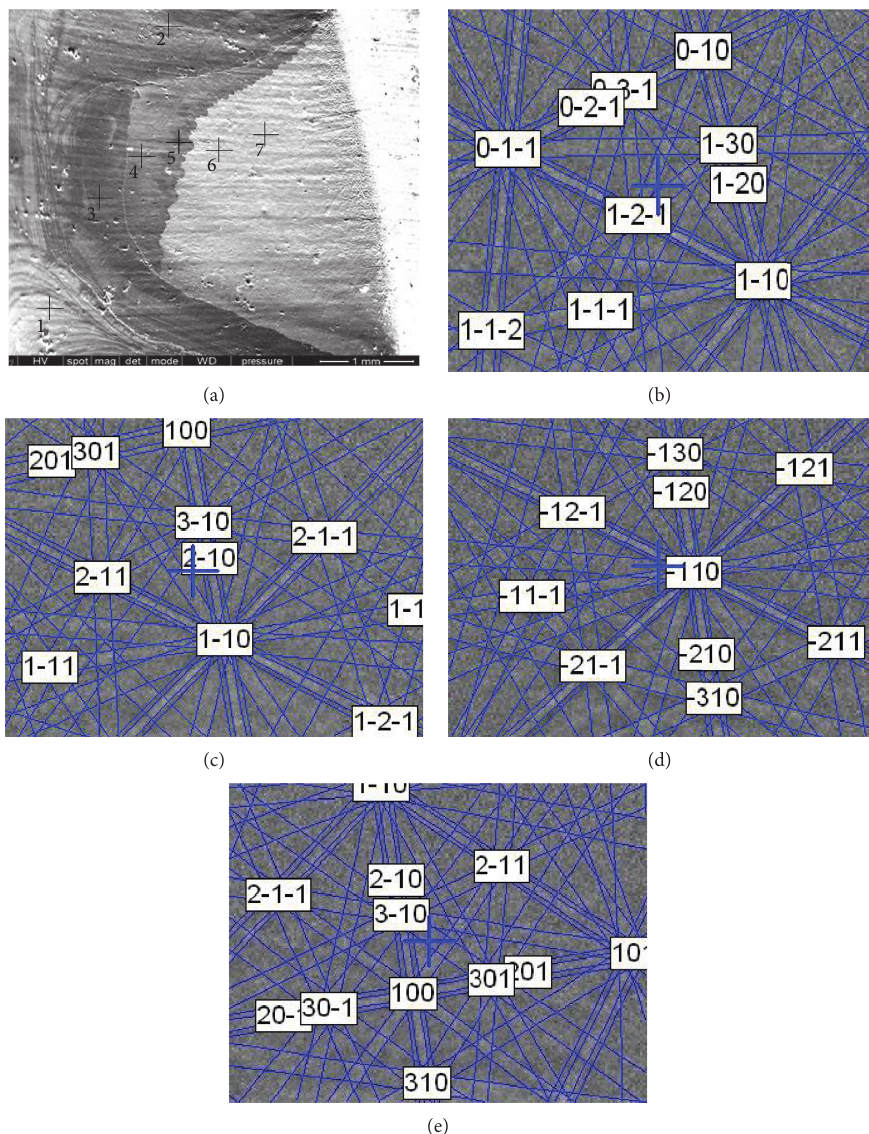
Figure 2: Transitional grains between abnormal grain and the matrix (orientation gradient and stress). (a) SEM micrograph of the abnormal grain (b–e) corresponding to the points 3, 5, 6, and 7 in